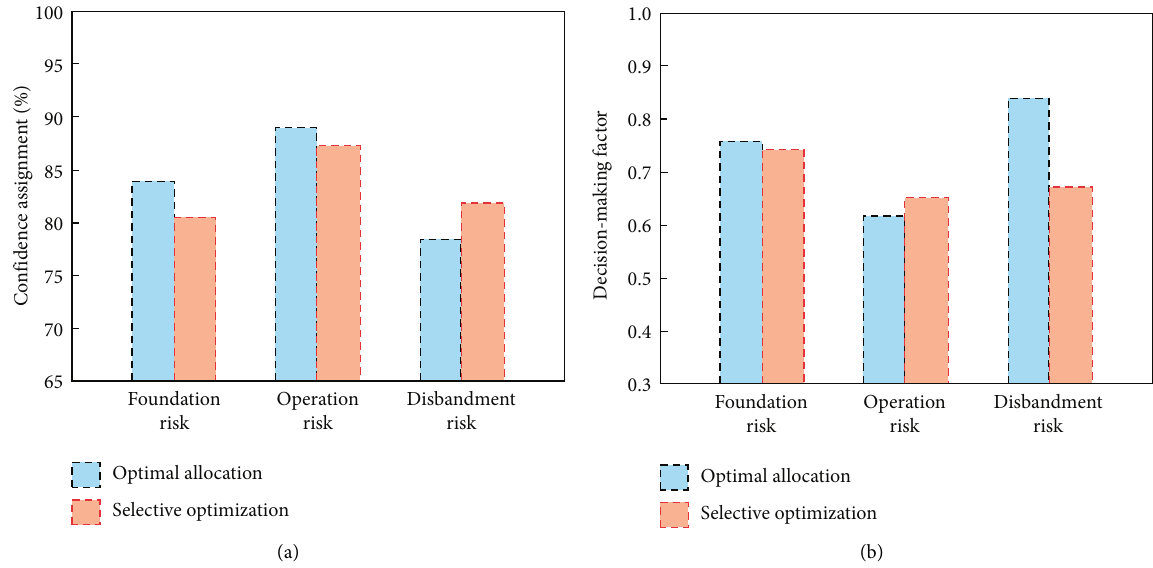
Figure 5: Confidence assignment (a) and decision-making factor (b) of the foundation, operation, and disbandment risk of virtual enterprise under optimal allocation and selective optimization.